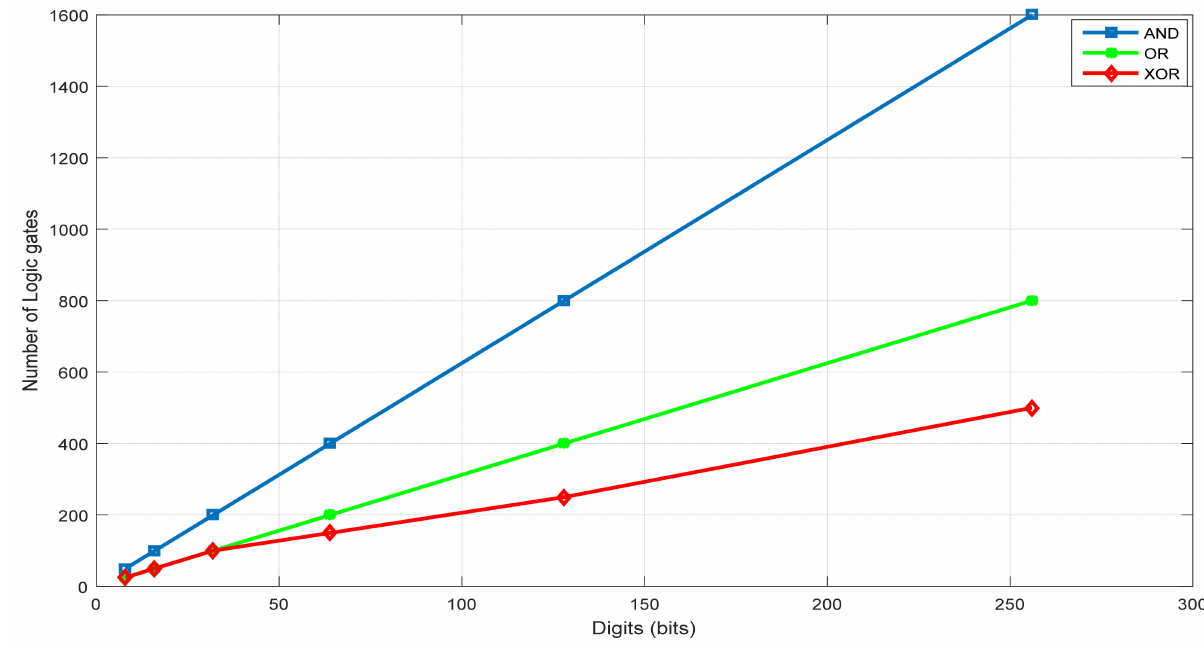
Figure 6. Logic gates versus F p